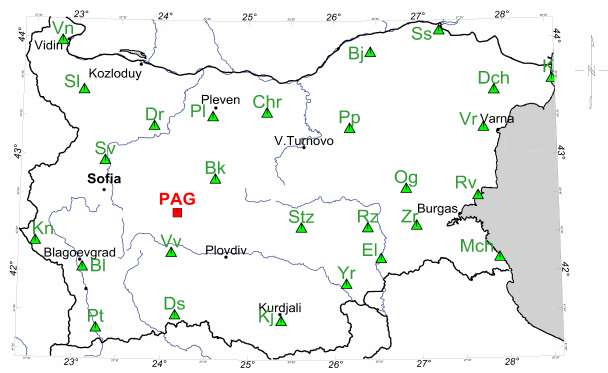
Figure 1. PAG observatory (red square) and repeat stations of Bul- garia (green triangles) used for geomagnetic model